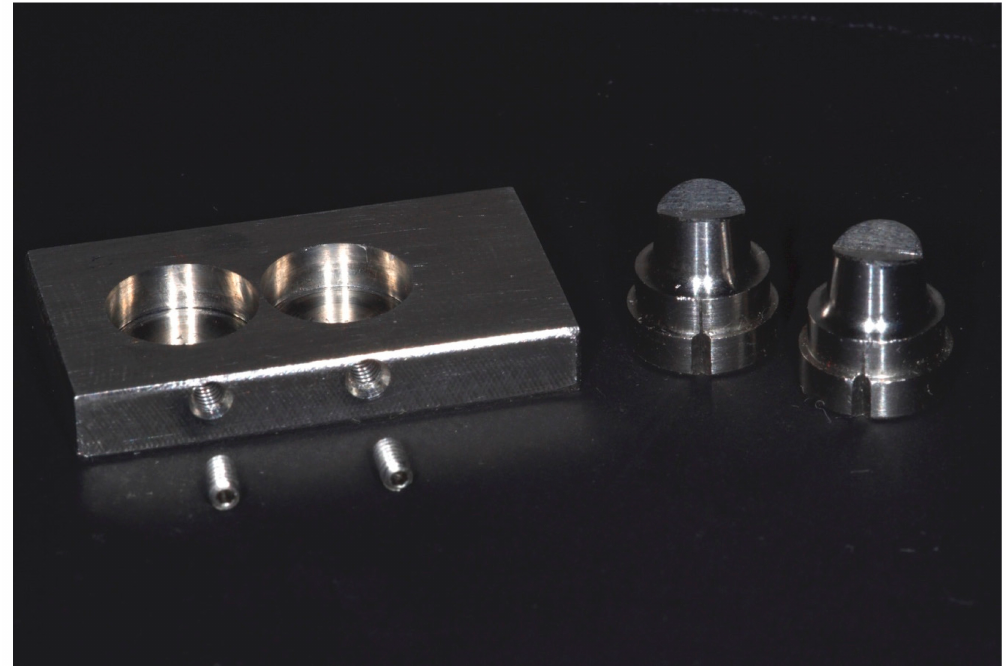
Figure 2. Master die components (platform, screws and abutments) of frameworks with cantilever pontic. Within each design group, the specimens were randomly divided into four subgroups (n = 10 each, in accordance with the results of power analysis) depending on the manufacturing technique used to fabricate the frameworks: casting (CM), laser sintering (LS), soft metal milling (SM) and hard metal milling (HM). The specimens were used as working dies.